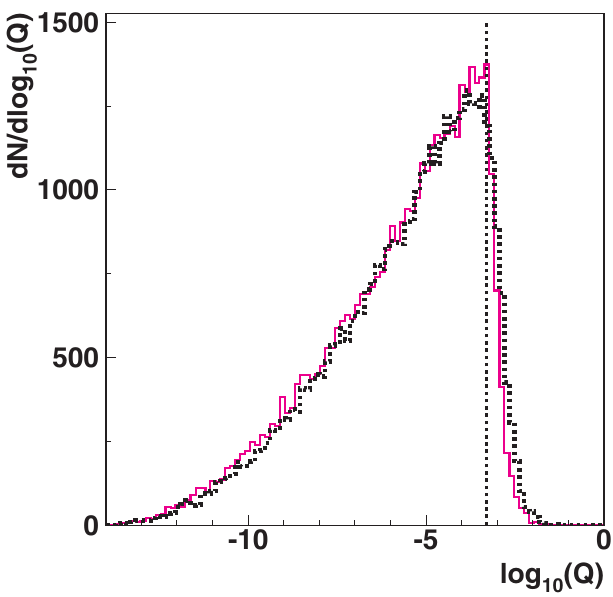
FIG. 9. (Color) Comparison of GUINEA-PIG and BDK (dashed thick line) photon virtuality decimal logarithm spectra, Q being in GeV. The vertical dashed line indicates the position of the electron